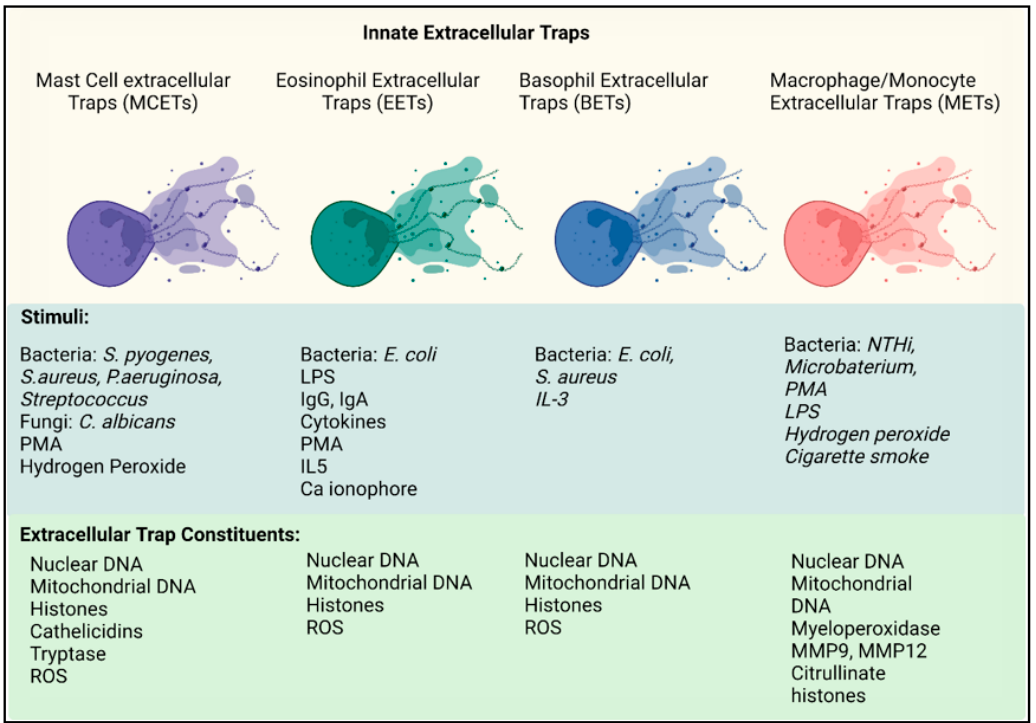
Figure 4. Innate extracellular traps. Mast cell extracellular traps (MCETs, purple) are stimulated by a range of pathogens including bacteria, fungi, PMA, and hydrogen peroxide. Once formed, MCETs consist of both nuclear DNA, mitochondrial DNA, histones and mast cell specific granules, tryptase, and chymase. Eosinophil extracellular traps (EETS, green) are simulated by bacteria, LPS, immobilized IgG and IgA, cytokines, IL-5, PMA, and Calcium ionophore. EETs are composed of DNA from both nuclear and mitochondrial origin, containing histones and ROS. Basophil extracellular traps (BETS, blue) are activated by bacteria and the cytokine IL-3. NET constituents are similar to that of EETS. Macrophage/Monocyte (METs, red) are activated by bacteria, PMA, hydrogen peroxide, and cigarette smoke. The webs contain nuclear DNA, myeloperoxidase, proteases: MMP9 and MMP12 and citrullinated histones. Figure created in Biorender.